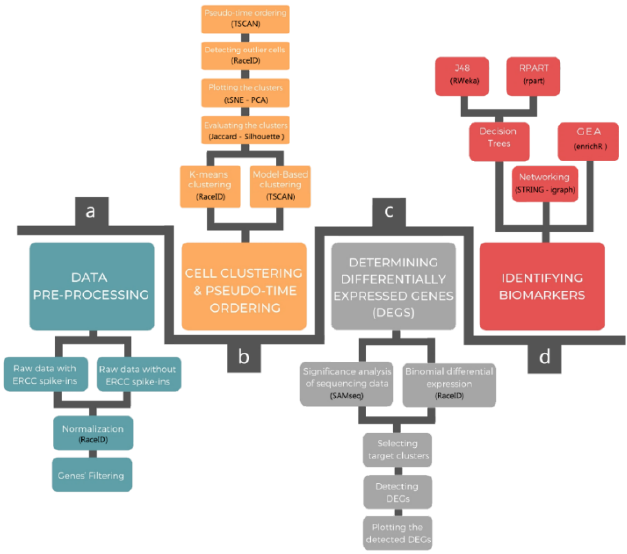
Figure 1. Overview of the DIscBIO pipeline showing its four successive sections. ( a ) Pre-processing the raw read counts with and without ERCC spike-ins. ( b ) Cell clustering and pseudo-time ordering. During this step clusters can be evaluated and visualized in PCA plots and t SNE maps with a possibility to detect outlier cells. ( c ) Identifying differentially expressed genes by SAMseq and binomial counting statistics. ( d ) Identifying biomarkers through decision trees, networking and gene enrichment